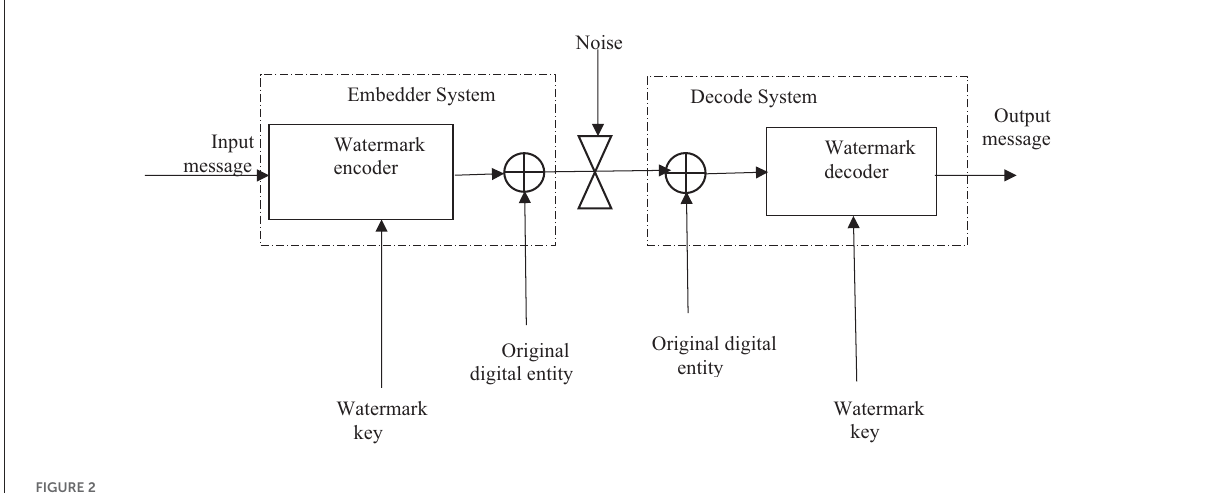
FIGURE2 Watermark system architecture for informed watermarking (Cox et al., 2008).